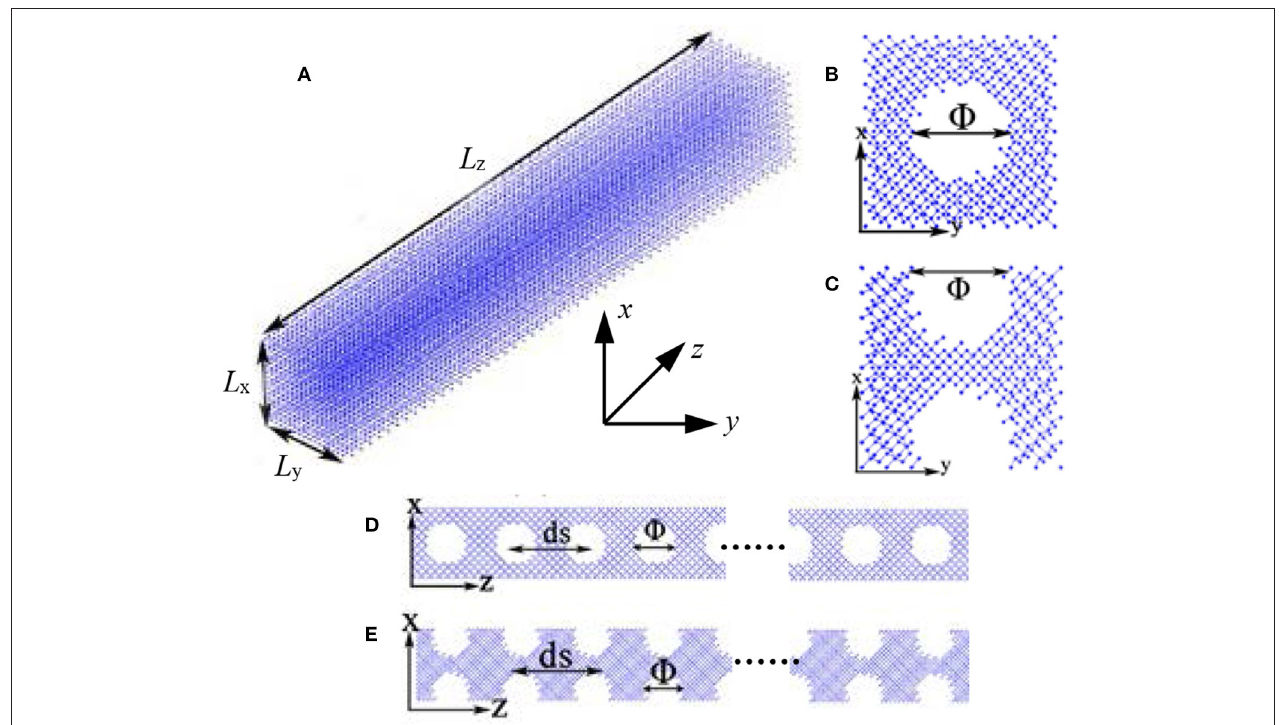
FIGURE 1 | Schematic of SiNWs in the current study: (A) SiNW with no defect, (B) left cross-sectional view of SiNW with inner defects, (C) left cross-sectional view of SiNW with surface defects, (D) front cross-sectional view of SiNW with inner defects, and (E) front cross-sectional view of SiNW with surface defects.